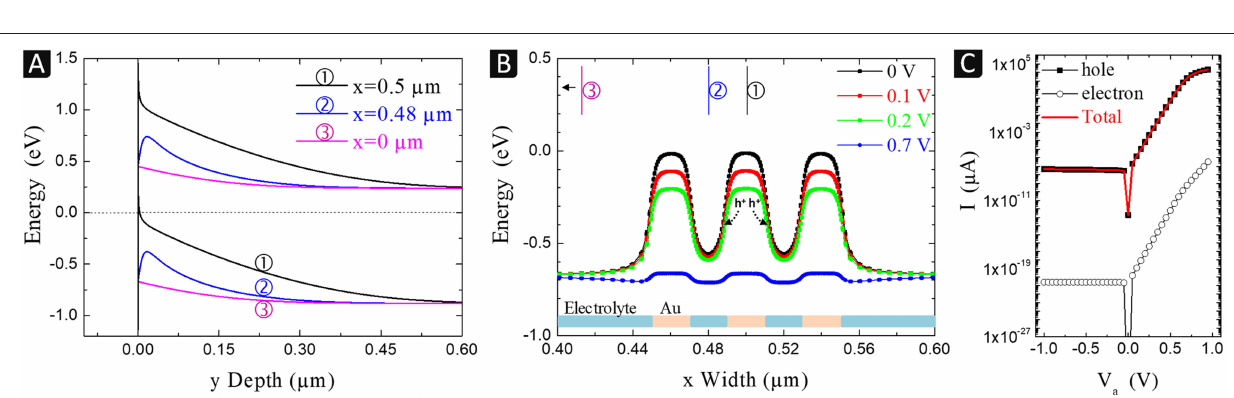
FIGURE 8 | Simulation of 3 gold ligaments (20nm in size and interspace) surrounded by an electrolyte and in contact with n-type silicon (3 × 10 15 cm − 3 ) through 2D profiles of the valence band energies (referenced to the Fermi level) at equilibrium, at low (A) and high (B) magnification. The VB energy color scale is given on the right-hand side.